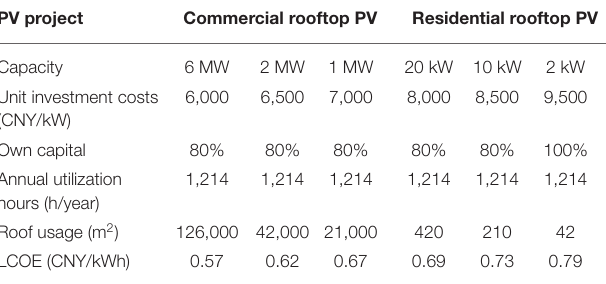
TABLE 3 | Baseline LCOE levels of rooftop PV projects at various scales.